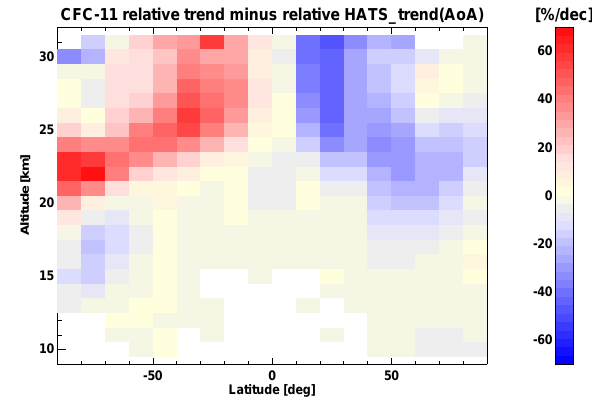
Fig. 13. Differences of relative trends between MIPAS and HATS data under consideration of the age of air over the years 2002 to 2011 as a function of altitude and latitude in % per decade for CFC- 11. The data gaps are due to missing age of air data. Numerical values are found in the supplement.